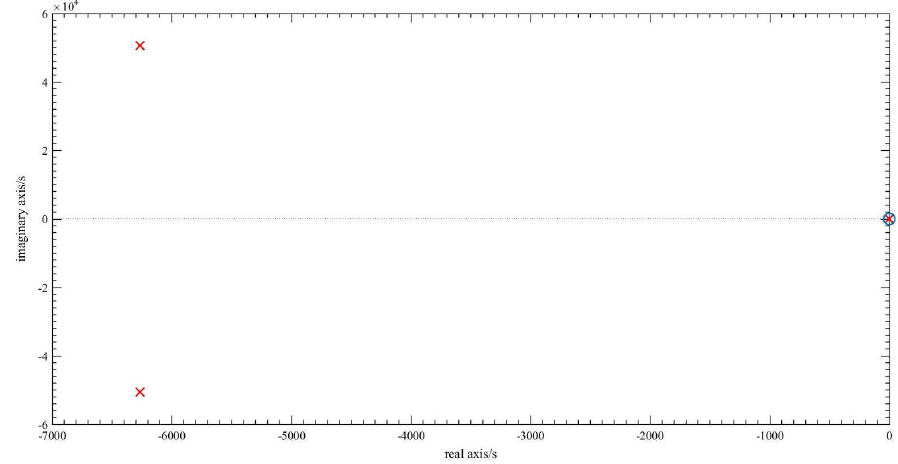
Figure 9. Bode diagram of ACR control system.